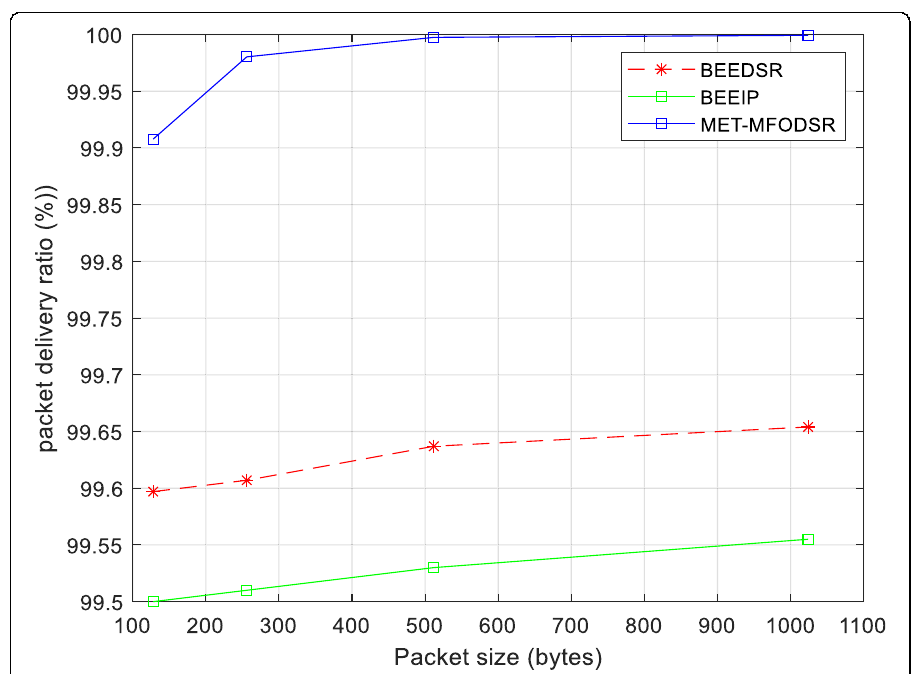
Fig. 6 Packet delivery ratio simulation results for BEEDSR, BeeIP, and MET-MFODSR. The simulation results of the packet delivery ratio under the packet size